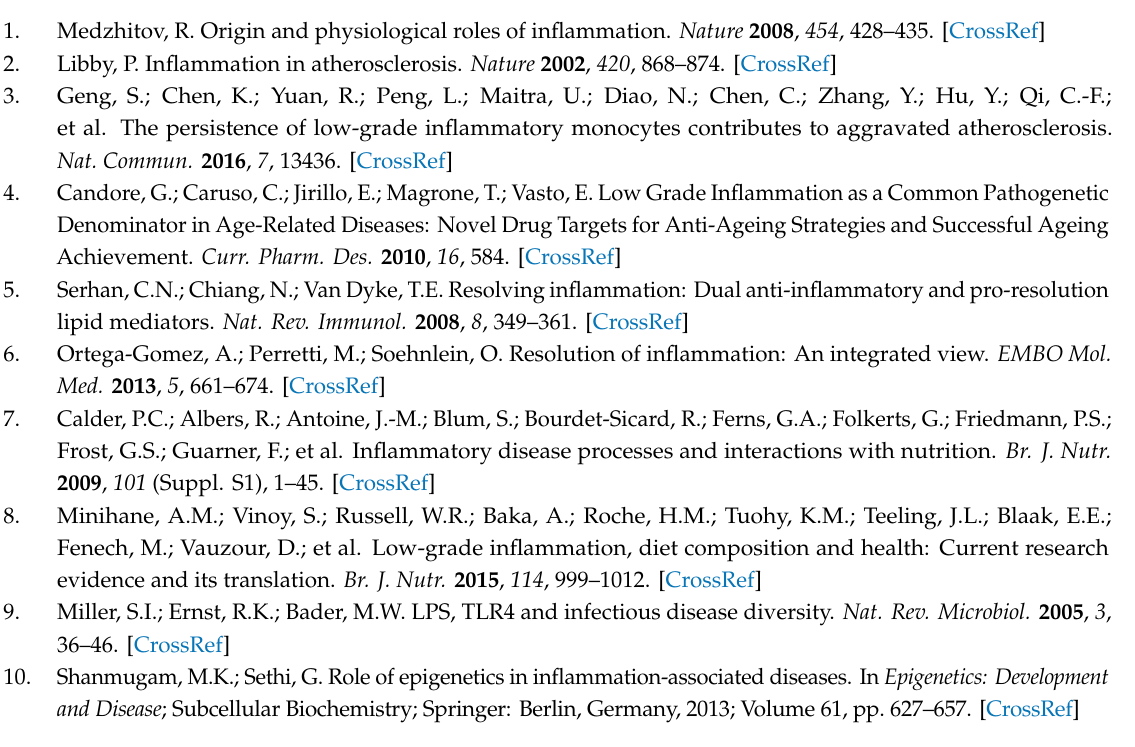
Table S1: Sequences of primers used for gene expression